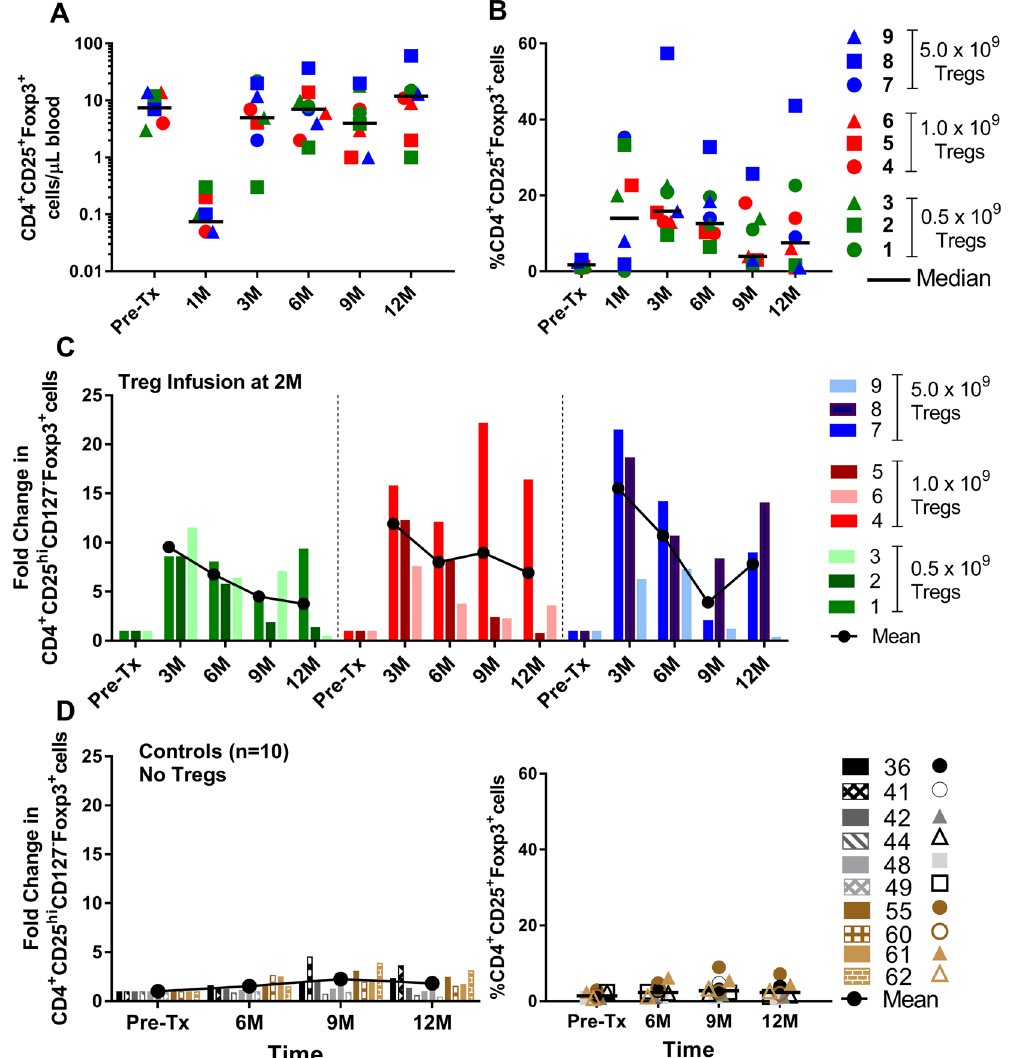
Figure 5. Immune monitoring for Tregs in recipients post Alemtuzumab induction and Treg infusion. ( A ) Absolute cell numbers per uL of blood, and ( B ) percentage of Tregs from pre-transplant to 12 months post- transplant in all nine recipients (n = 9). ( C ) Fold Change in the percentage of Tregs within all nine recipients post Treg infusion when normalized against the pre-transplant percentages. ( D ) The controls were 10 renal transplant recipients treated with the same conditioning and immunosuppression but did not receive